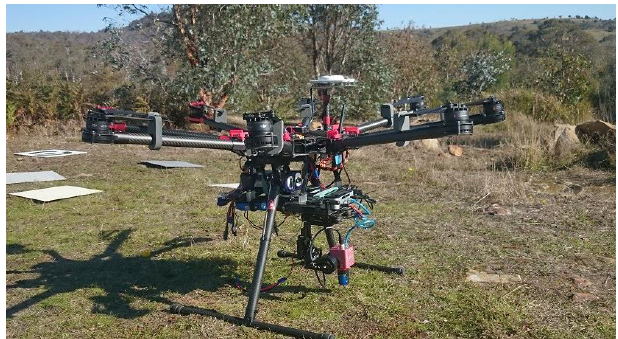
Figure 1. The DJI S-1000 multi-rotor flight platform, with downward facing PhotonFocus camera attached to the 2-axis gimbal and Trimble GNSS receiver mounted on top.